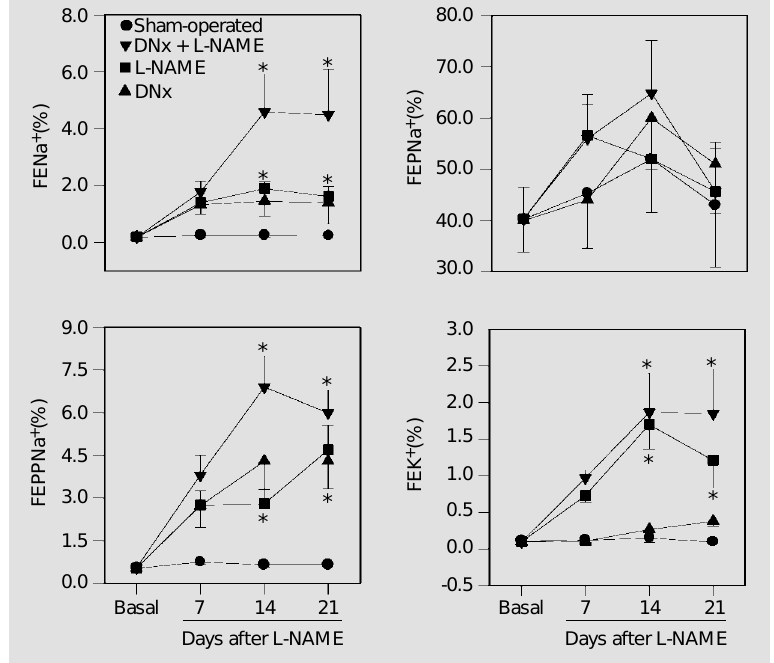
Figure 2 - Effect of oral L-NAME administration on fractional sodium (FENa + ) and potassium (FEK + ) excretion, and fractional proximal (FEPNa + ) and post-proximal (FEPPNa + ) tubule sodium excretion in sham-operated rats compared to bilaterally renal denervated (DNx) rats. The data are reported as the mean ± SEM for 10 rats per group. *P<0.05 compared to the sham-operated vehicle-treated or sham-operated L-NAME-treated animals (ANOVA and Bonferroni’s contrast